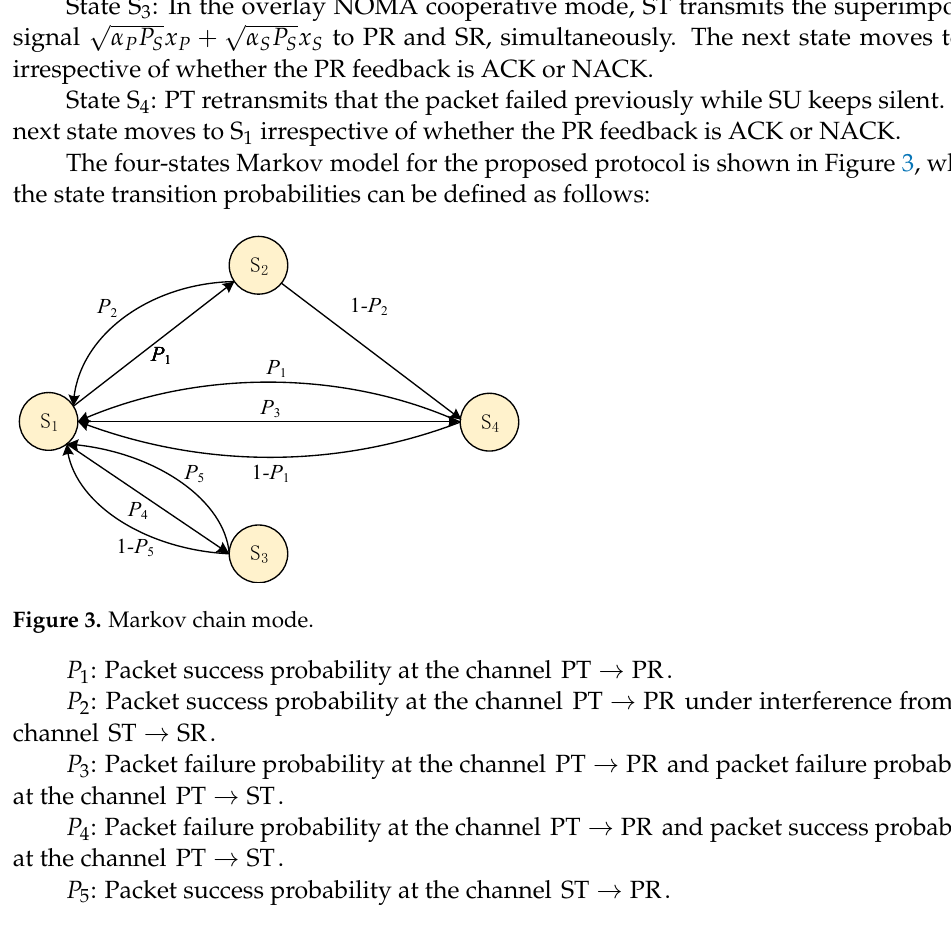
Table 1. Hybrid cooperative cognitive radio networks based on OMA/NOMA of transmission state.